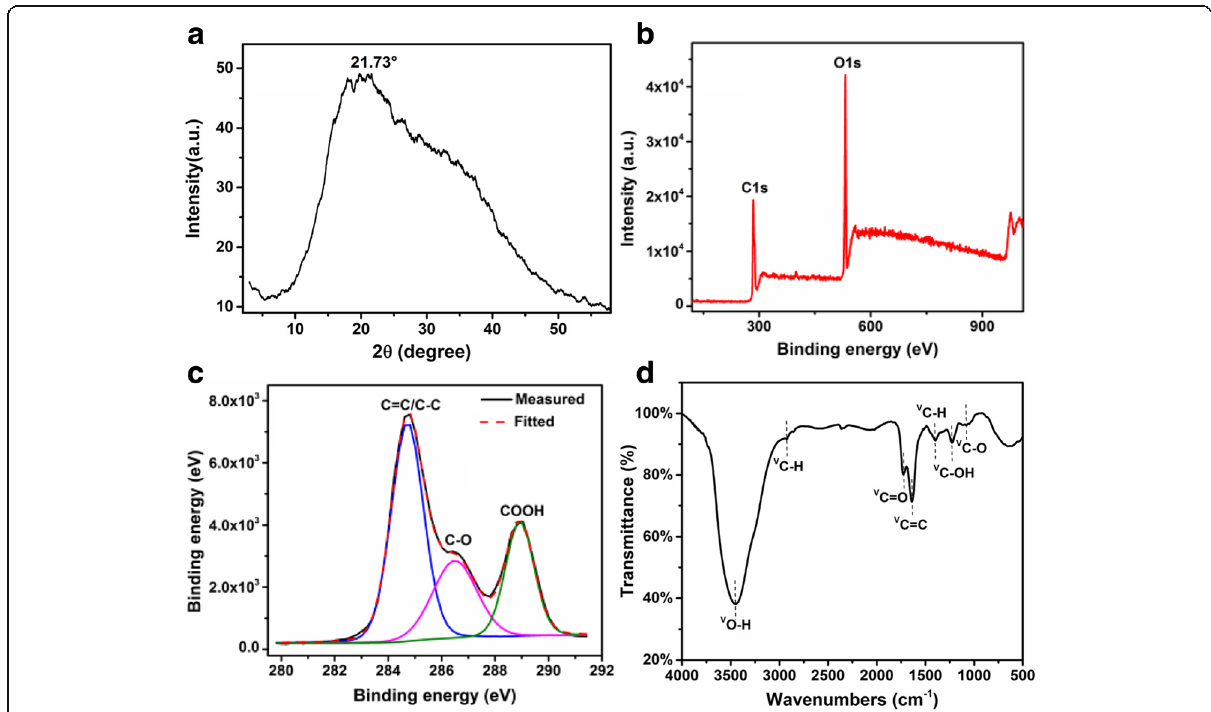
Fig. 3 a XRD pattern. b Low-range XPS spectra. c XPS high-resolution scan of the C1s region. d FTIR spectra of